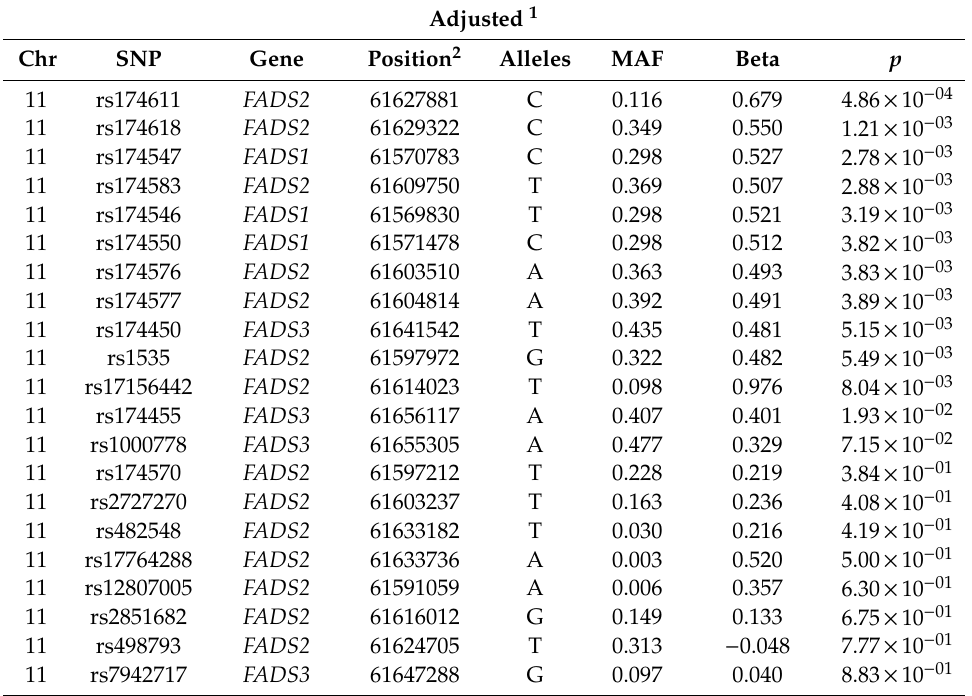
Table 4. Top-ranked SNPs in the RWAS for the FADS1 / FADS2 / FADS3 region in determining serum linoleic fatty acid concentrations (%) in the whole